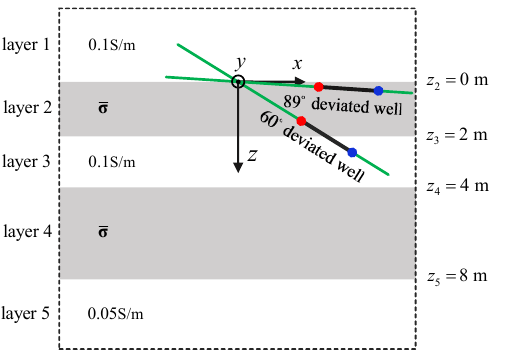
Figure 8. Five-layer anisotropic model and two deviated well logging trajectories in the formation coordinates xyz . Layers 2 and 4 share the same tensor conductivity σ .